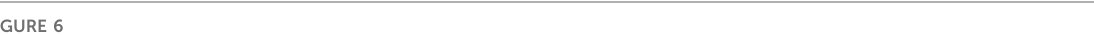
FIGURE 6 maize CK2 α structure in complex with AMPPNP and magnesium ions (PDB ID: 1LP4 (Yde et al., 2005)) served as a reference for the binding mode of AMPPNP and magnesium ions in this fi gure. (E) Mutation sites involved in substrate binding. To illustrate the substrate binding mode, a peptide substrate(colouredblue)wasmodelledintothesubstratebindingsiteasdescribed(Nie fi ndetal.,2007).Sulfateionspresentinthestructuremarkthe anion binding sites for the substrate. Mutation sites which are relevant for substrate binding from the P+1 loop (Arg191 and Ser194, Phe197, Lys198 and Gly199, dark salmon), catalytic loop (Met153 and His160, dark cyan), activation loop (Leu178, yellow) and the basic cluster (Arg80, light blue) are shown as stick representations. In addition to the mutated residues, Arg155 is shown as stick representation, as it creates a positively charged anion binding site together with Arg80 which is required for substrate recognition at the P+3 position. The CK2 α 1-335 structure (PDB_ID: 2PVR (Nie fi nd et al., 2007)) was used for the fi gure. (F) Mutation sites in the subunit interaction interface. Critical residues for binding on the CK2 α (Leu41 and Phe54, pale cyan) and CK2 β (Tyr188 and Phe190, grey) surface are shown as sticks. The mutation site Tyr39 is not directly involved in the interaction but stabilizes the protein fold through a hydrogen bond to Asp99. To illustrate the movement of the β 4 β 5 loop upon assembly of the CK2 holoenzyme, the closed conformation of the CK2 α monomer (pale cyan) and the open conformation of CK2 α with bound CK2 β (grey) are shown. The CK2 α 1-335 structuremonomer(PDB_ID:2PVR (Nie fi nd etal.,2007))and theCK2 holoenzymestructure(PDB_ID: 4DGL(Lolli etal.,2012)) were used for the fi gure. (G) Cis -con fi guration of the Pro231. The mutation site Pro231 is located in the C-terminal segment of CK2 α . Pro231 was foundas a cis -peptide inall CK2 α structures publishedso far.Pro231 islocated inproximitytotheP+1loopanditsmutation toanon-proline residue lacking cis -peptide propensity may disturb the local or even global fold of the protein. The CK2 α 1-335 structure (PDB_ID: 2PVR (Nie fi nd et al., 2007)) was used for the fi gure. (H) Mutation sites inthehydrophobic cluster aroundMet153and the C-terminal region.The mutation site Met153 ispart ofa hydrophobic cluster and resides in close proximity to Leu213 and the aromatic rings of Tyr188, Tyr209, Tyr211. The mutation site Arg312 forms a critical salt bridge with Glu201 of the P+1 loop/activation segment. Position Arg312 is in close proximity to the mutation site Asp210 and to a critical watercluster,whichmediatesthecontactoftheN-terminalsegment(lightpink),theactivationloop,andthe α Chelix,whichkeepsthemintheactive conformation.TheCK2 α 1-335 structure(PDB_ID:2PVR(Nie fi ndetal.,2007))wasusedforthe fi gure.Electrondensitiesaroundwatermoleculeshavea cutoff level of 2 σ